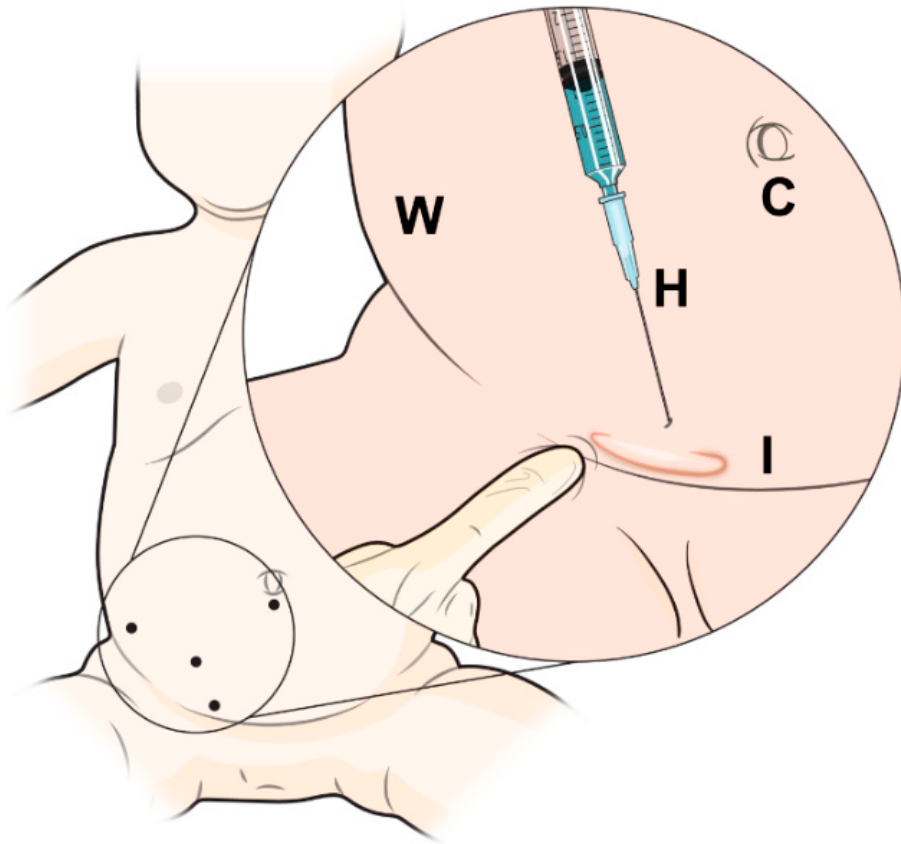
Figure 1. Schematic image of laparoscopic glue hernioplasty. C : Camera, W : Abdomen wall, H : Histoacryl ® , I : Inguinal ring